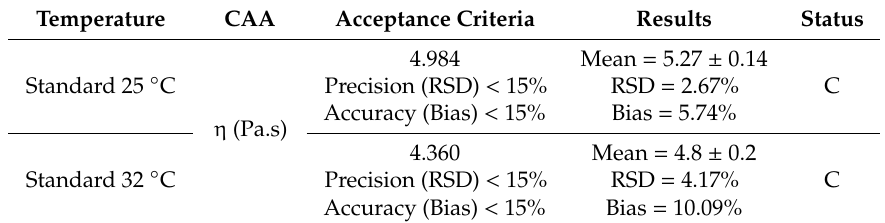
Table 2. Predefined acceptance criteria and results for equipment qualification tests. Interday results report to a n = 3 performed on three consecutive days. A Newtonian standard with known viscosity was used as reference.